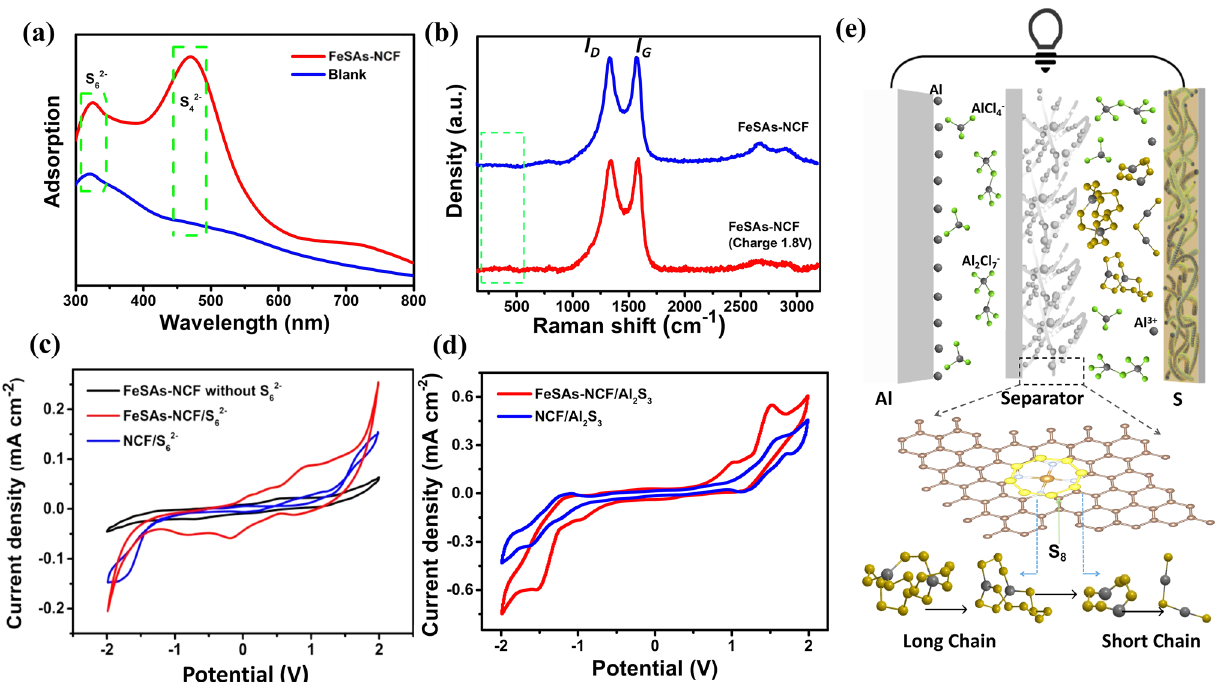
Fig. 4 a UV–Vis spectra of the electrolytes in the Al–S batteries with FeSAs-NCF and the blank cell after charge/discharge. b Raman spectra of pristine FeSAs-NCF and the FeSAs-NCF collected at a charge state of 1.8 V. c CV curves of the symmetric cells in the electrolyte containing S 2 − 6 . d CV curves of the symmetric cells with Al 2 S 3 . e Schematic illustration of inhibiting shuttle effect and catalyzing aluminum polysulfides of the Al–S battery with